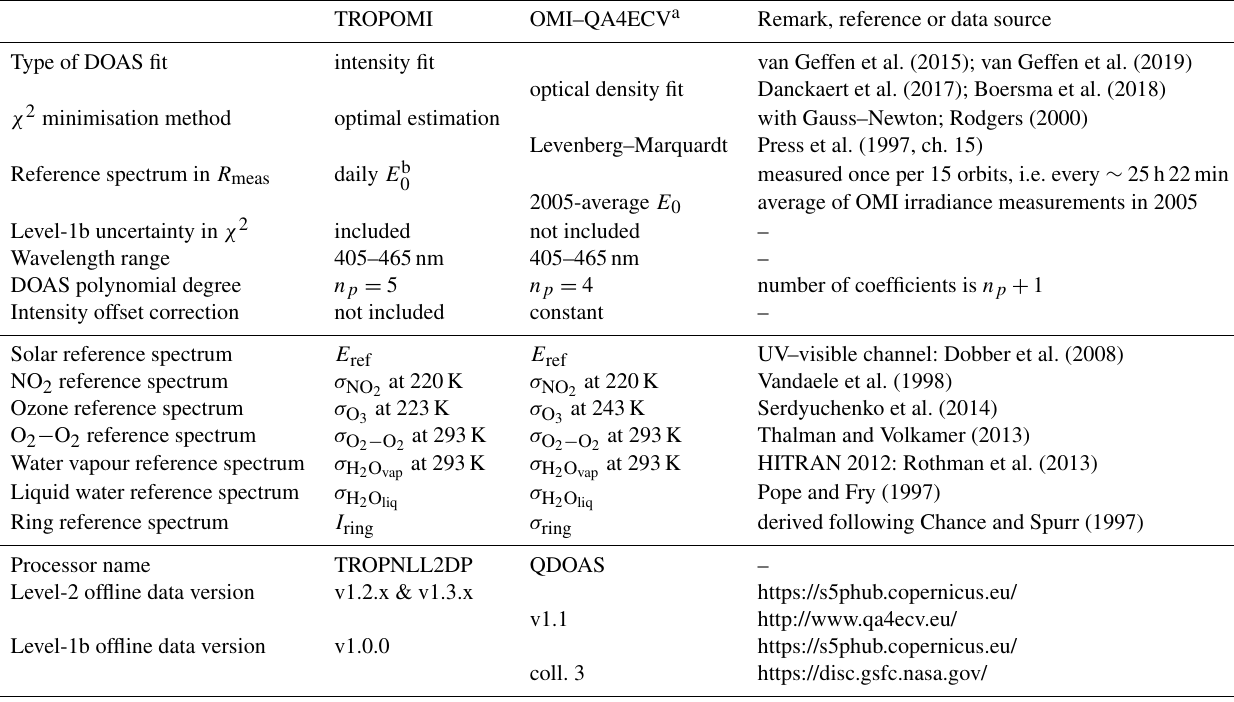
Table 1. Specifics for the NO 2 slant column retrieval of TROPOMI and OMI–QA4ECV. The reference spectra (second group of entries) have all been convolved with the row-dependent instrument spectral response function (ISRF or slit function). Last access dates for all